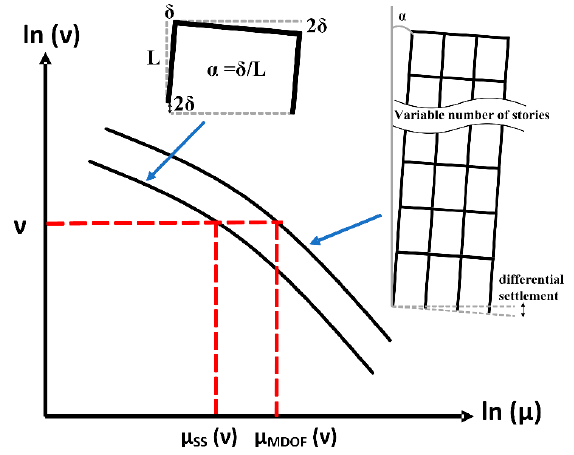
Figure 10. Schematic representation related to the estimation of the ductility transformation factors (DTF).